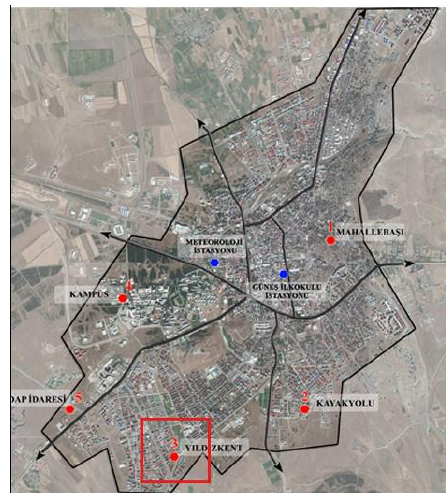
Figure 2. Satellite Image of the Study Area 2